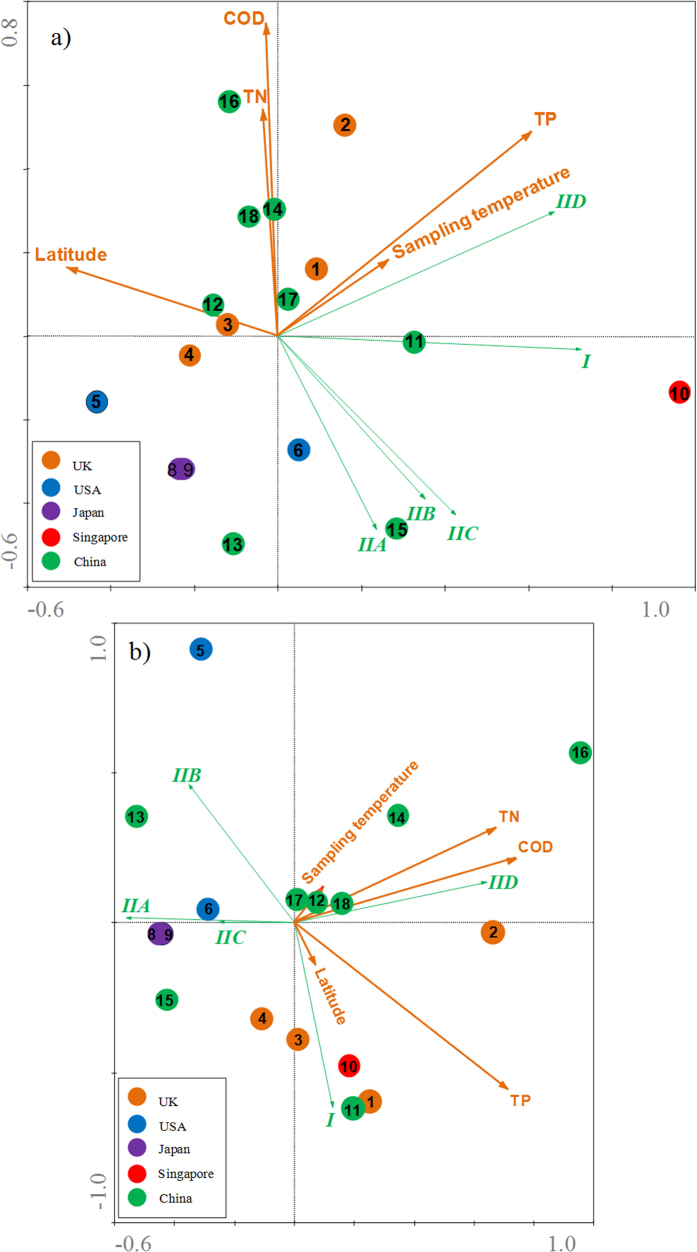
Correlation triplots based on redundancy analysis (RDA) displayed the variations of relative abundances of Accumulibacter specific-clade ina) the bacterial communities and b) the Accumulibacter lineage, basing on the qPCR assays targeting ppk1 genes and bacterial 16S rRNA genes, with respect to the variable operational conditions among wastewater treatment plants. Each Accumulibacter clade is represented in green line, each activated sludge sample is indicated by a color point. Operational variables are indicated by orange lines.